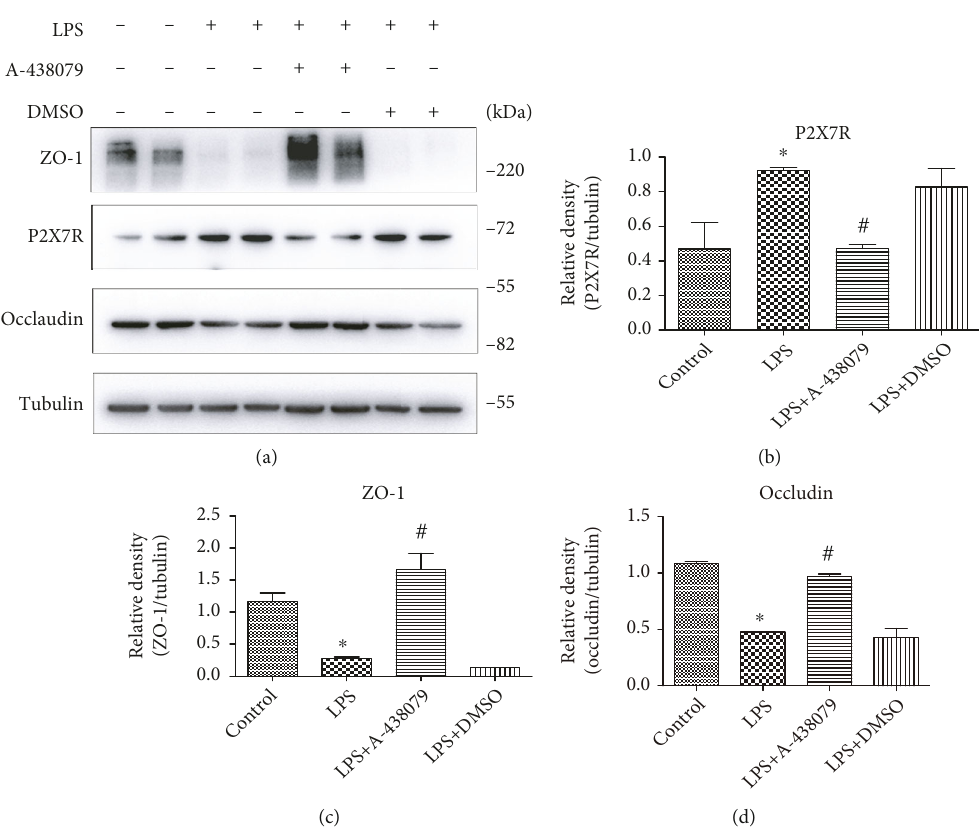
Figure 2: Treatment with the P2X7R inhibitor A-438079 improved LPS-induced decline in tight junction protein expression in the mouse hippocampus. (a) The expression levels of ZO-1, P2X7R, and Occludin were detected by Western Blot. Respective bands with Tubulin as loading controls are shown. (b) The expression of P2X7R was signi fi cantly increased in the hippocampus of mice after intraperitoneal injection of LPS. All data are expressed as mean ± SD . ∗ P < 0 : 05 vs. control. (c) and (d) LPS signi fi cantly inhibited the expression of tight junction proteins ZO-1 and Occludin in the hippocampal tissues of mice, while A-438079 reversed this e ff ect. All data are expressed as mean ± SD . ∗ P < 0 : 05 vs. control, and # P < 0 : 05 vs. LPS